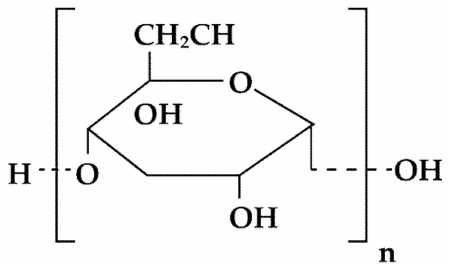
Figure 5. Schematic illustration of maltodextrin